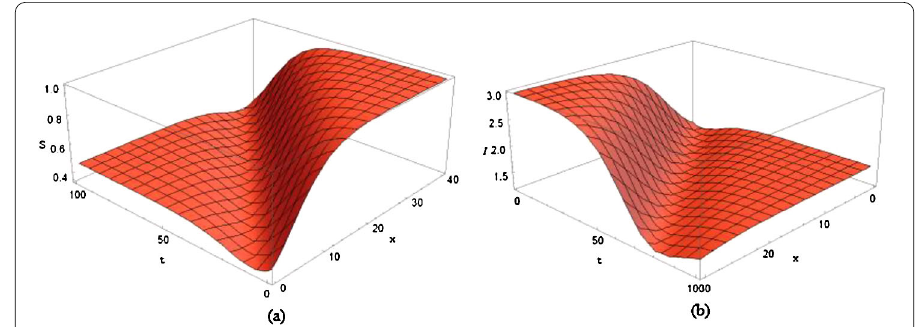
Figure 3 Three dimensional plots of the analytic solution of (4)-(6) with the same set of parameters as those shown in Figure 2, given in the text. (a) S ( x , t ); (b) I ( x , t